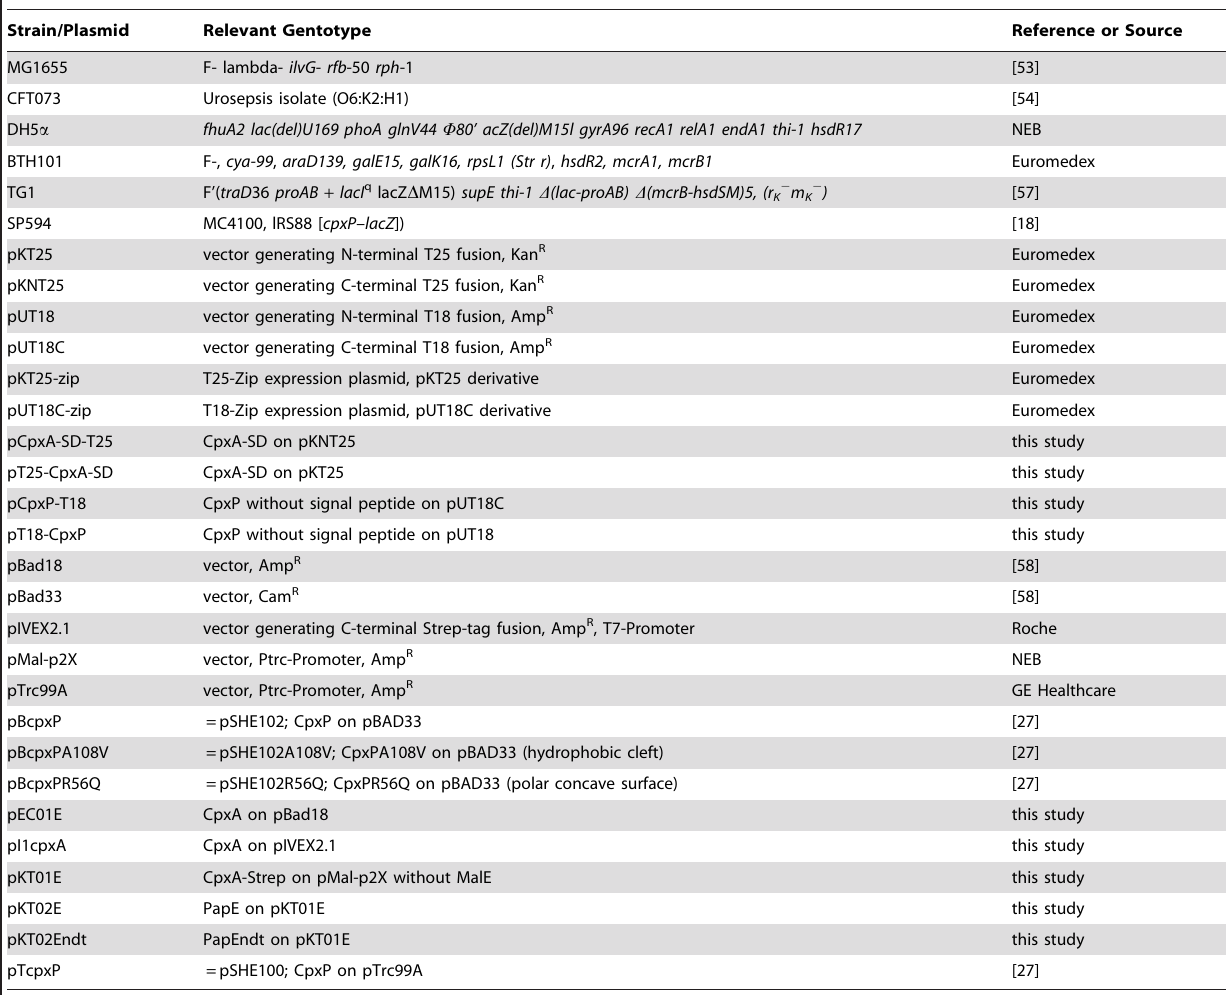
Table 1. E. coli strains and plasmids used in this study.